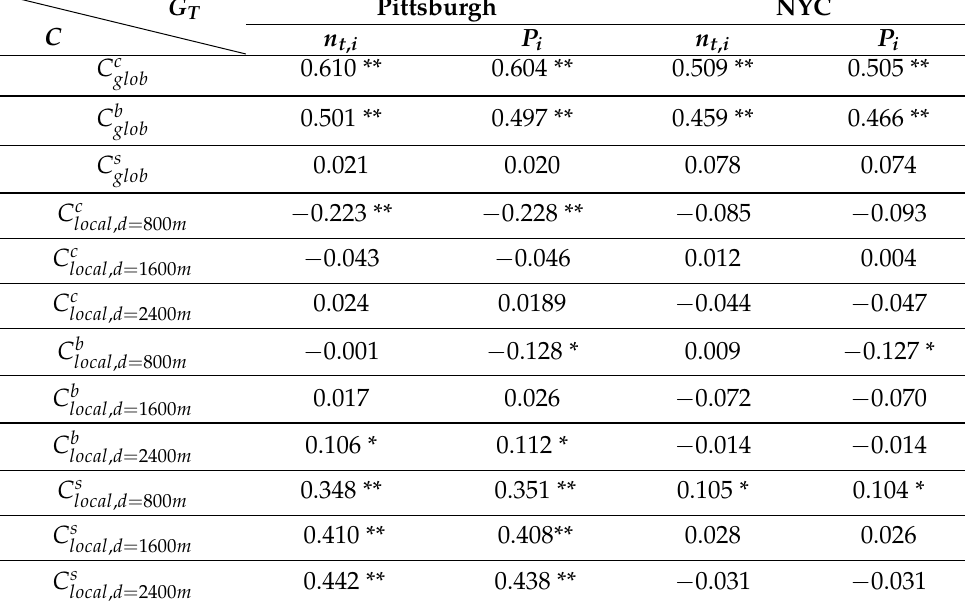
Table 3. Correlation ρ (* indicates a p -value < 0.05; ** indicates p -value < 0.01) between the street centrality and the intensity of human